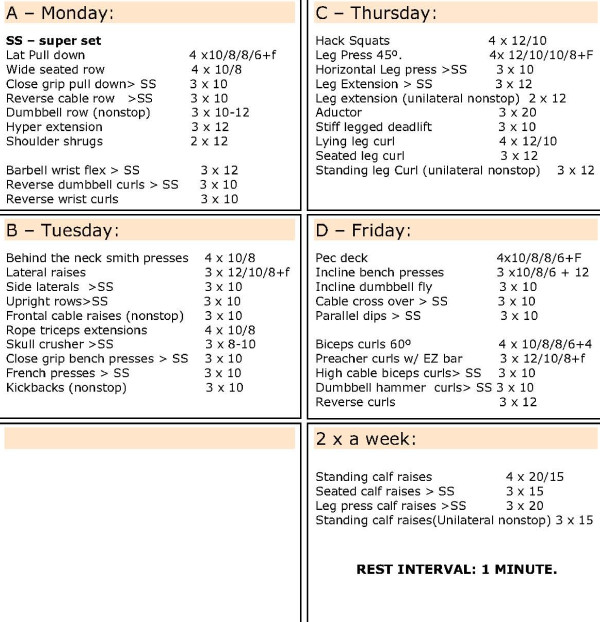
Training Routines